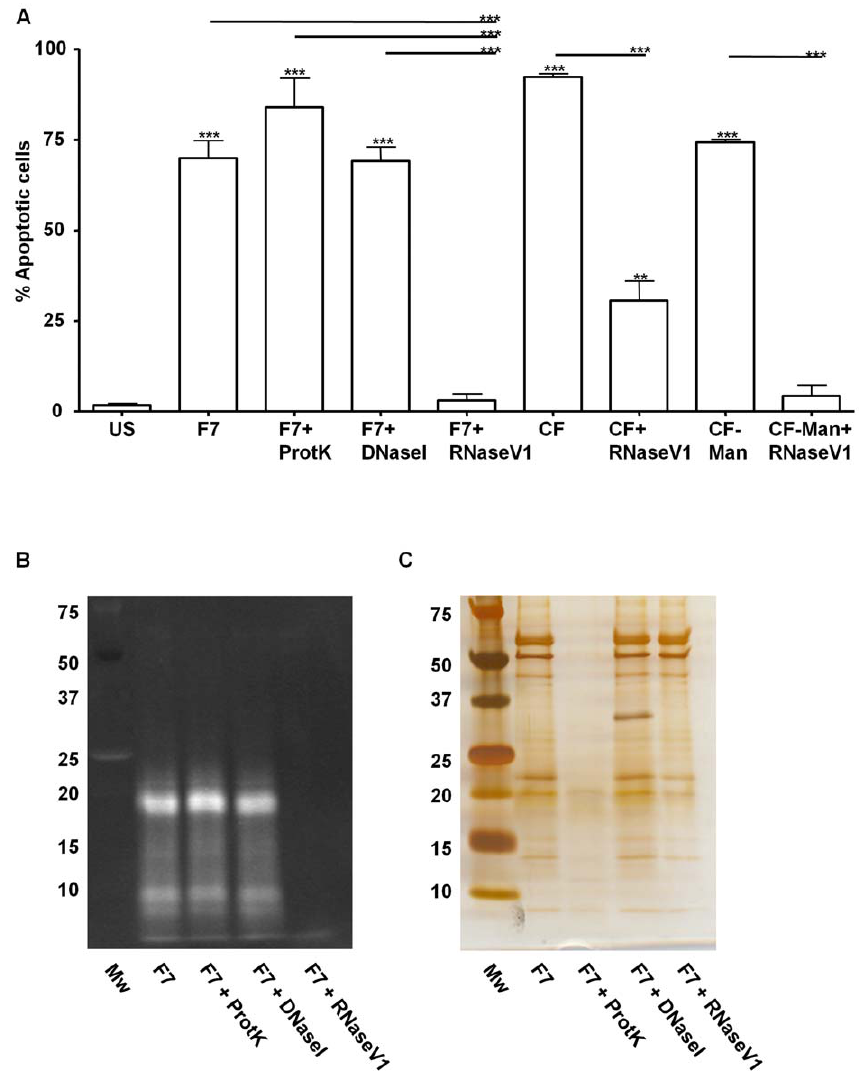
Figure 2. RNA in DEAE-Sepharose Fraction 7 induces apoptosis in human monocytes. A. Apoptosis induced by DEAE-Sepharose Fraction 7 (F7), F7 treated with proteinase K (F7 + ProtK), F7 treated with DNase1 (F7 + DNase1), F7 treated with RNaseV1 (F7 + RNaseV1), CF, CF treated with RNaseV1 (CF + RNaseV1), CF-Man, CF-Man treated with RNaseV1 (CF-Man + RNaseV1). Apoptosis was measured by flow cytometry and presented as percentage of human monocytes that stained annexinV positive. *** significance p , 0.001, ** significance p , 0.01 as compared to unstimulated control or between treated samples. B. SDS-PAGE with ethidum bromide staining and C. silver staining of F7 and F7 treated with proteinase K, DNase1, or